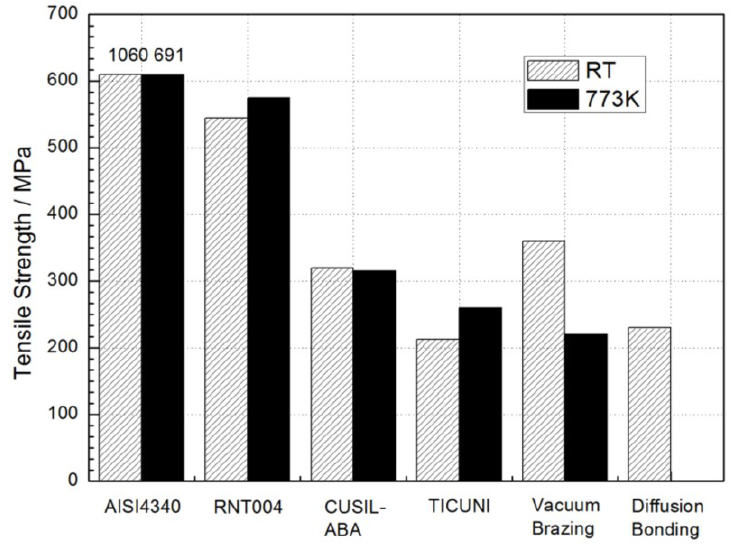
Figure 4. Tensile strength of TiAl joints. (Reprinted with permission from [14].